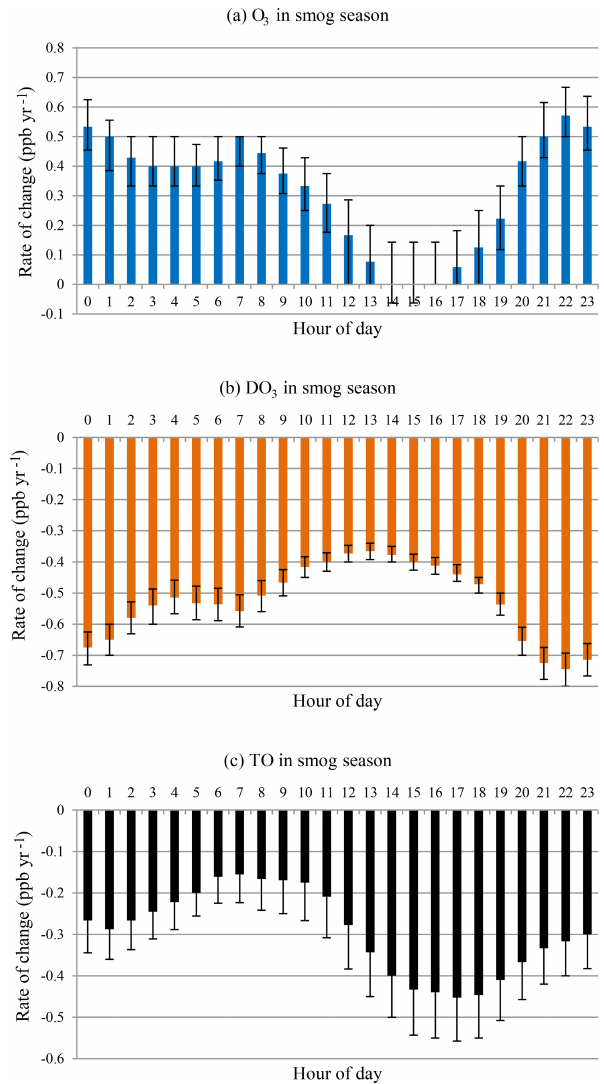
Figure 7. Rate of change by hour of day for all months during 1996– 2015 for (a) O 3 , (b) DO 3 , and (c) TO.